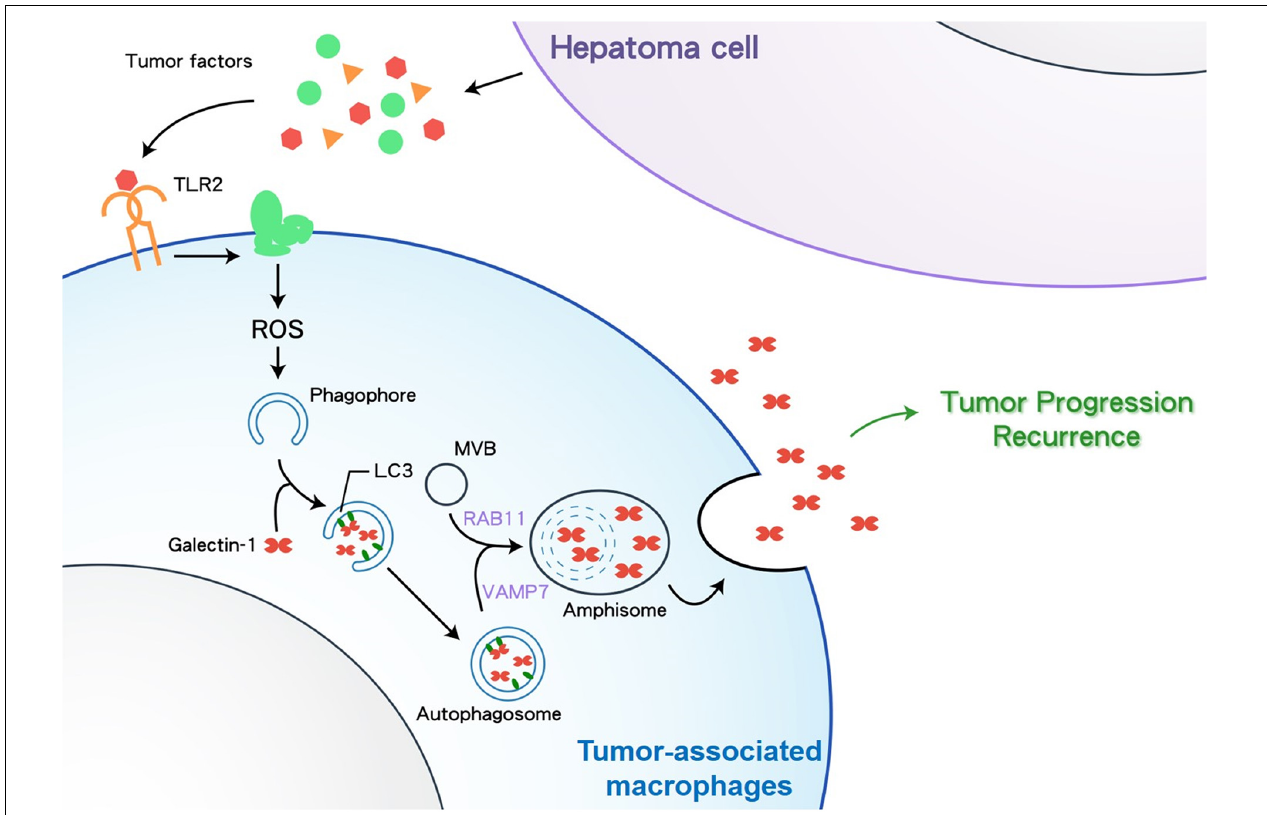
FIGURE 6 | A schematic diagram depicting how HCC cells stimulate TAMs to secrete Gal-1 via secretory autophagy. TLR2, Toll-like receptor 2; ROS, reactive oxygen species; MVB, multivesicular body; VAMP7, Vesicle associated membrane protein